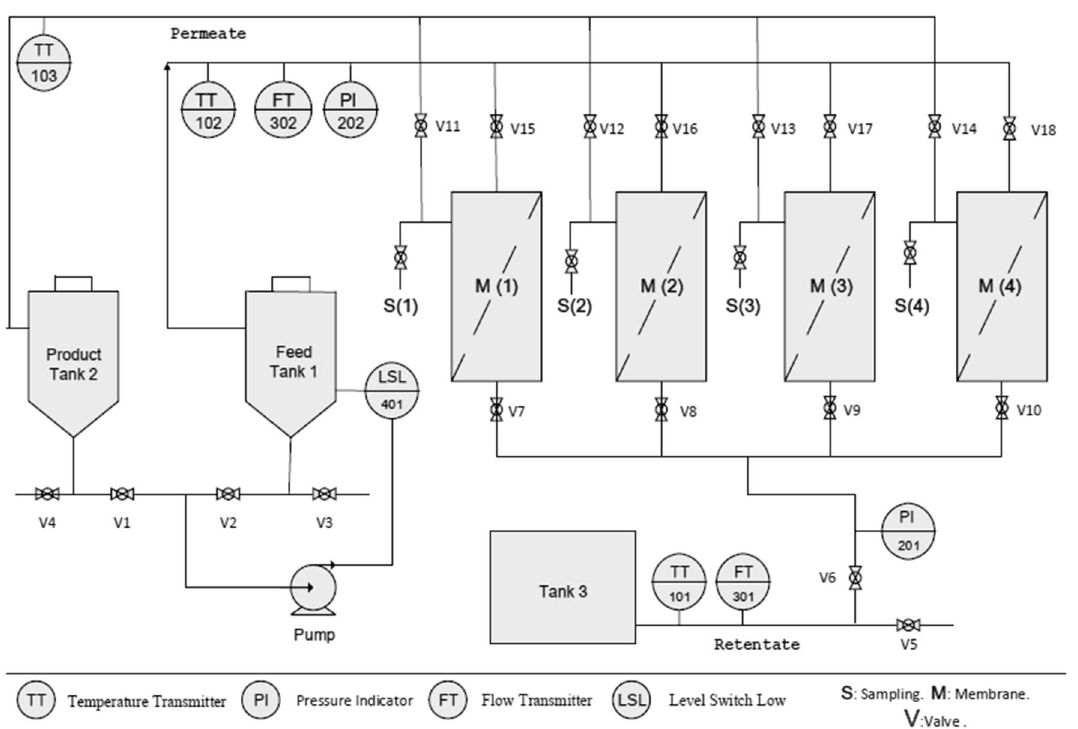
Fig. 5 Process flow diagram of the membrane filtration test unit; model: TR 14 (SOLTEQ Company: Solution Engineering 2008 and ITT PCI Membranes Ltd 2011)